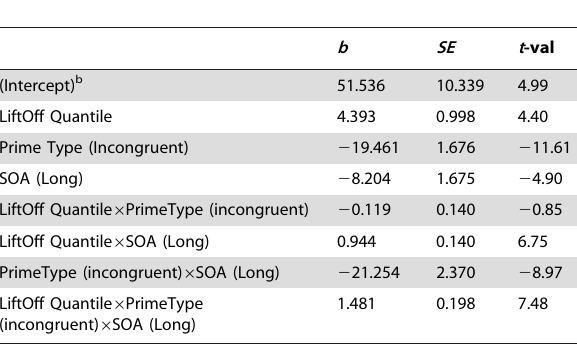
Table 2. Fixed effects for Expt 1B estimated with LMM a .